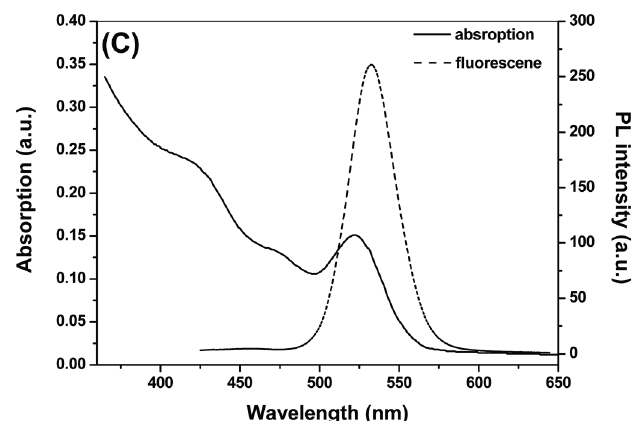
Figure 1. Characterization of CdTe QDs. ( A ) TEM of CdTe QDs; ( B ) Size distribution by dynamic light scattering (DLS) CdTe QDs; ( C ) Absorption and photoluminescence (PL spectrum of CdTe QDs).